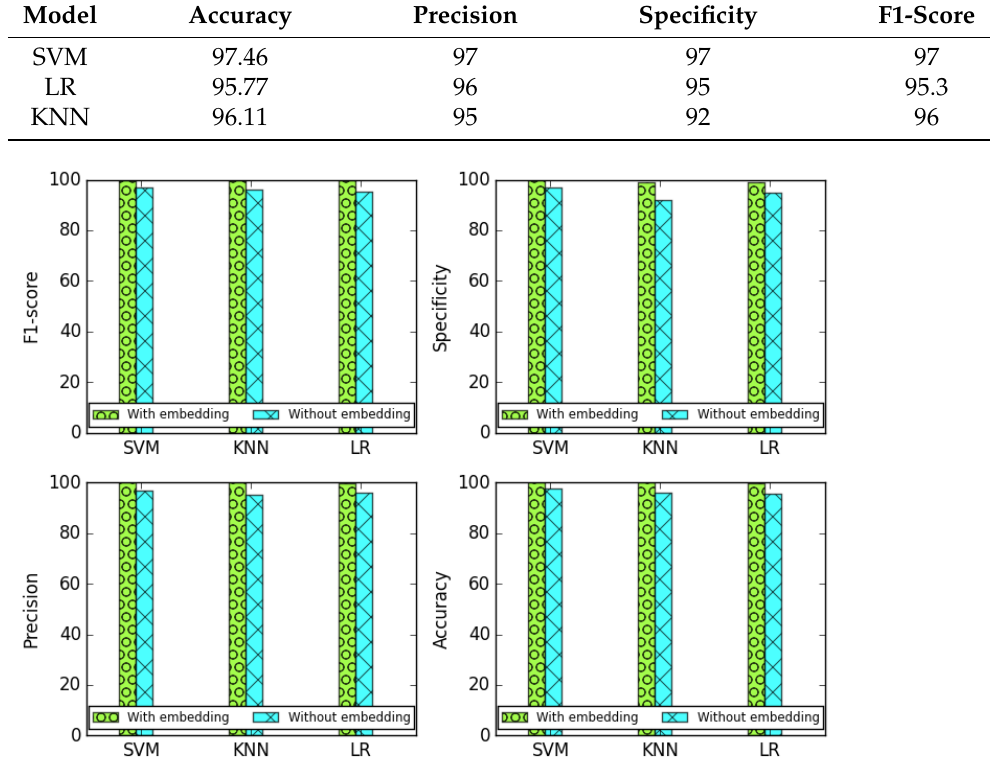
Table 9. Classification results of water zones without embedding.